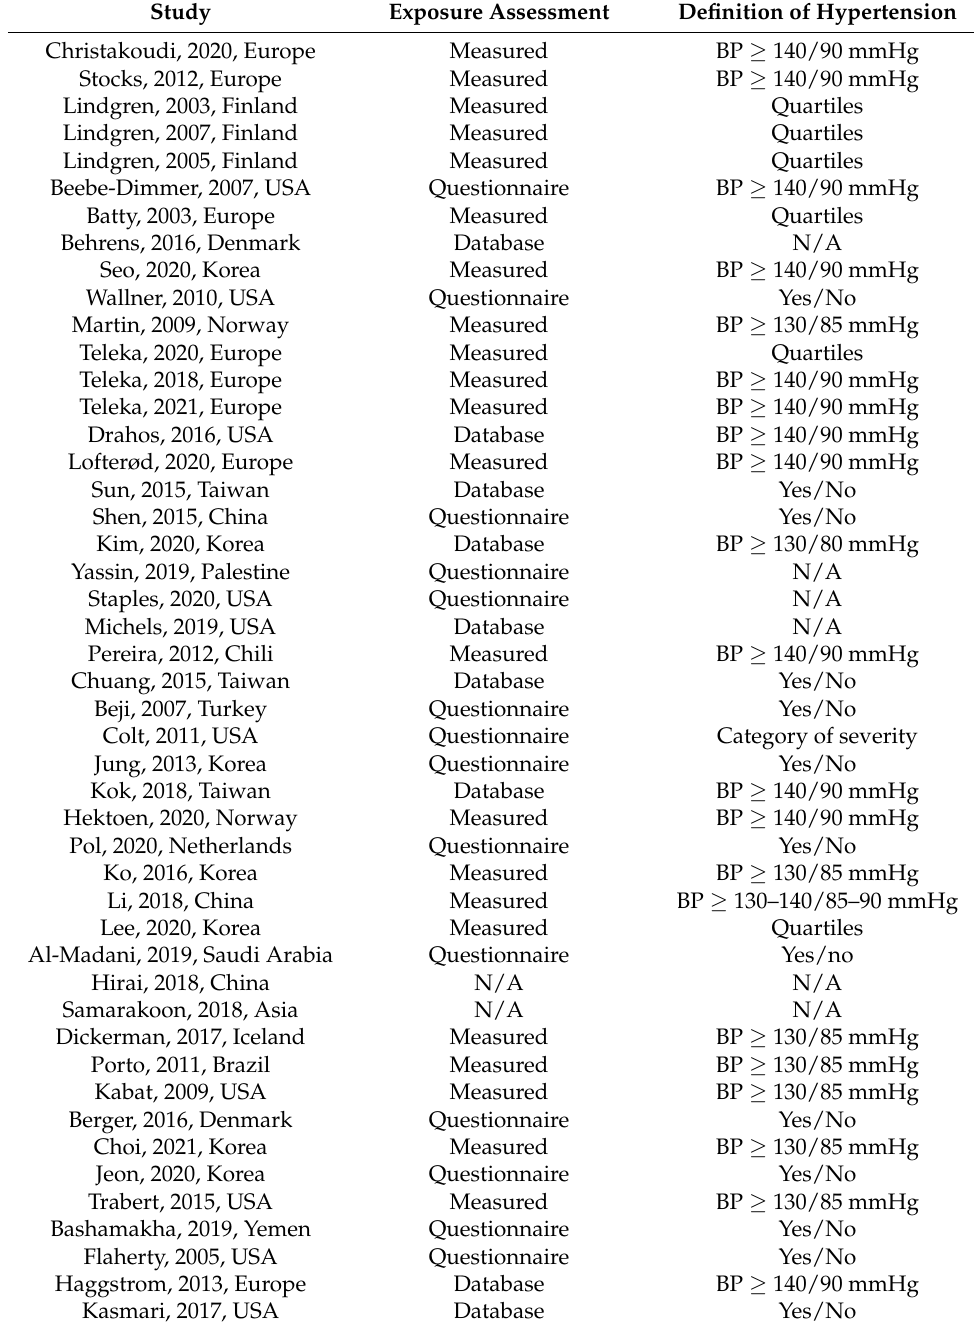
Table 2. Hypertension assessed and defined by each